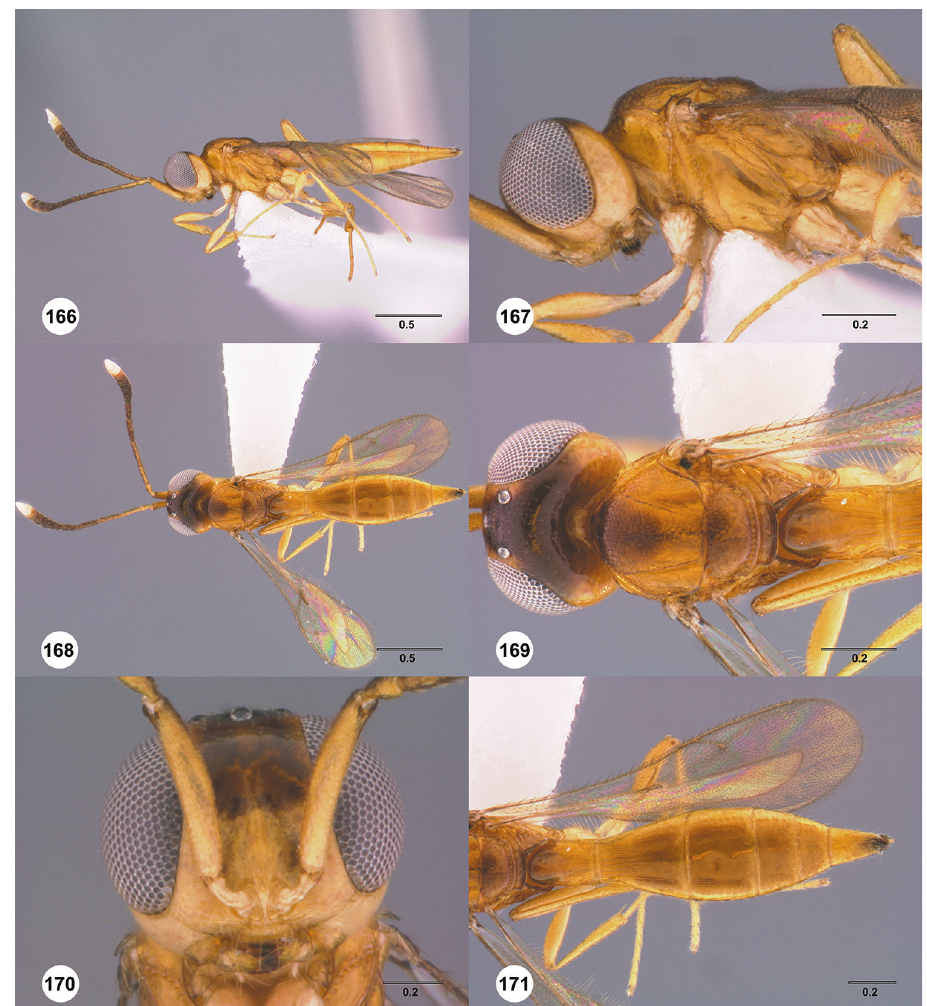
Figures 166–171. Calliscelio migma sp. n., female, holotype (OSUC 380181). 166 Lateral habi- tus 167 Head and mesosoma, lateral view 168 Dorsal habitus 169 Head and mesosoma, dorsal view 170 Head, anterior view 171 Metasoma, dorsal view. Scale bars in